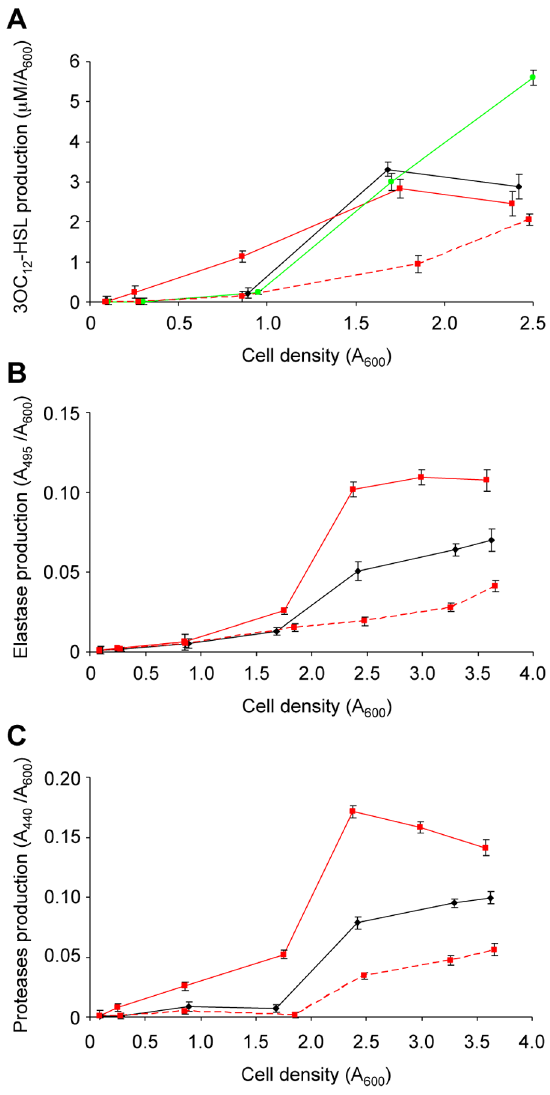
Figure 2. Effect of QS dysregulation caused by qteE mutation on P. aeruginosa virulence-related phenotypes. Levels of (A) 3OC 12 -HSL, (B) elastase, (C) proteases produced along growth by P. aeruginosa wild type (black lines), qteE (red lines) and rsaL strains (green line) carrying the pBBR1MCS-5 empty vector, or by the qteE strain carrying the pQteE plasmid (pBBR1MCS-5-derived) for the expression of qteE (dashed red line). Values are the means ( 6 standard deviations) of at least three independent